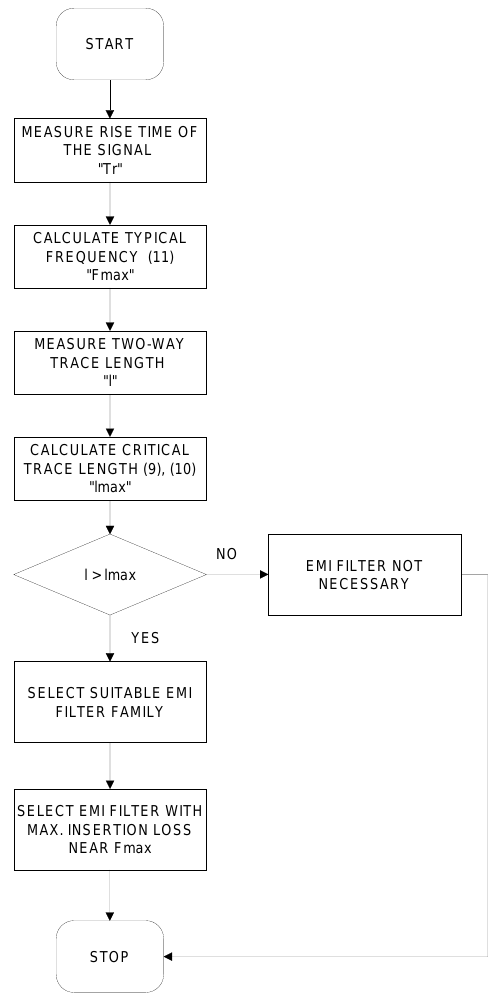
Figure 6. EMI filter selection flow chart.